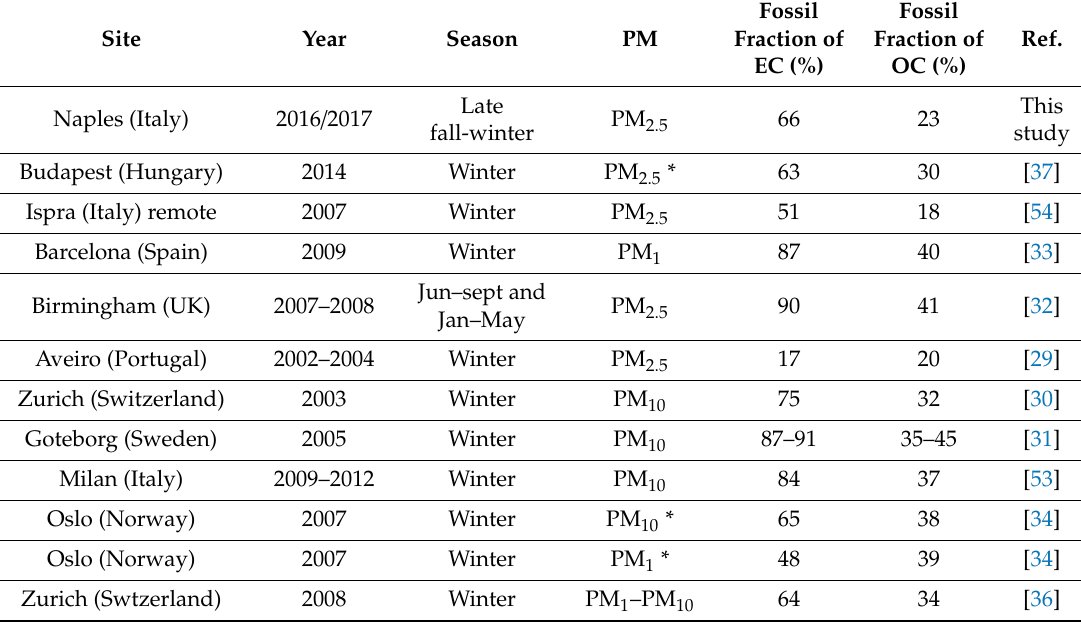
Table 3. Fossil fuel fractions of OC and EC reported for di ff erent European cities (see last column for the proper reference to published data), where cold season campaigns of 14 C-based apportionment studies have been